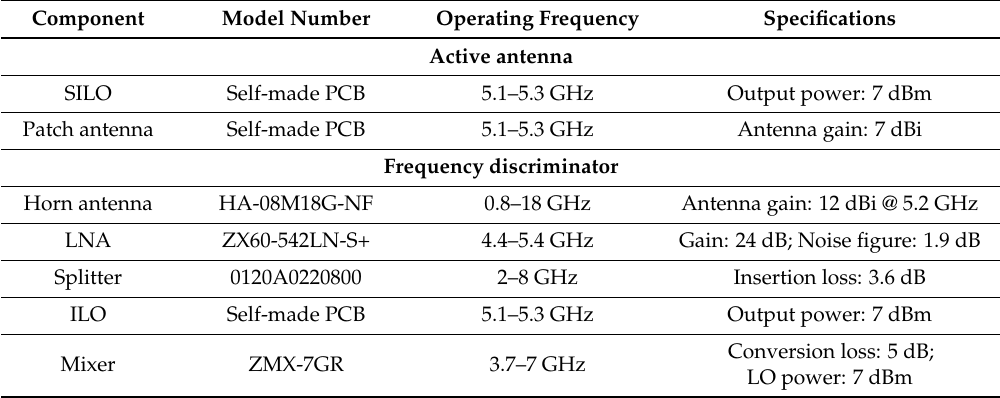
Pulse @ 1.675 Hz Peak = 1.800 (mV)